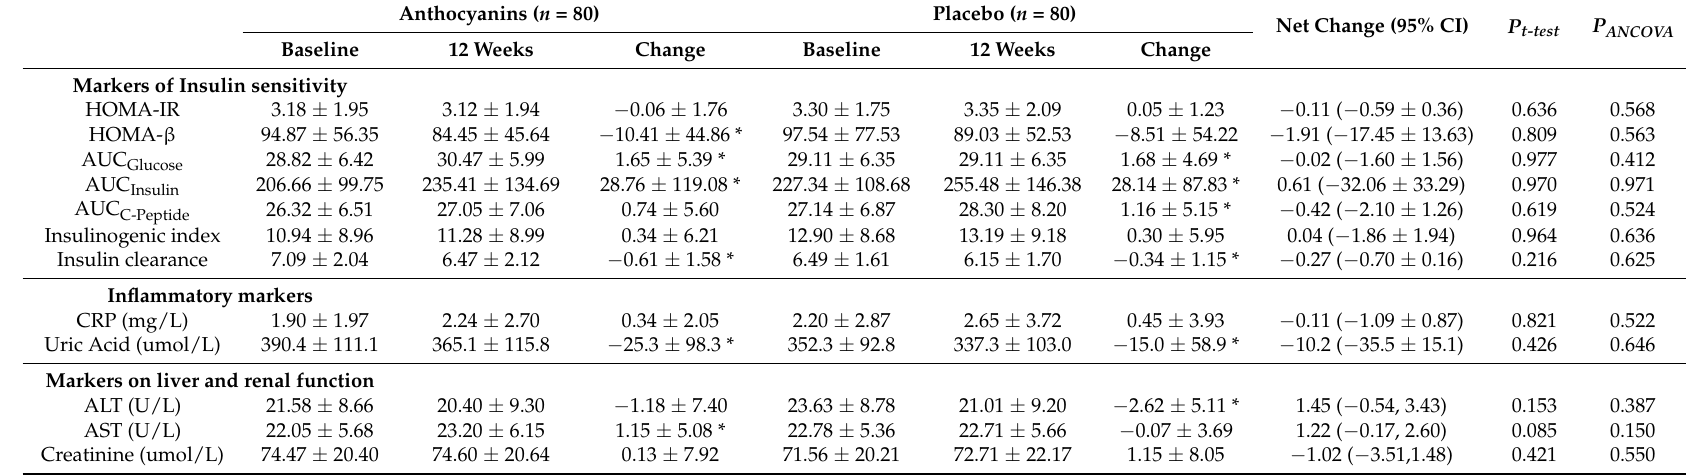
Net Change (95% CI) P t-test P ANCOVA